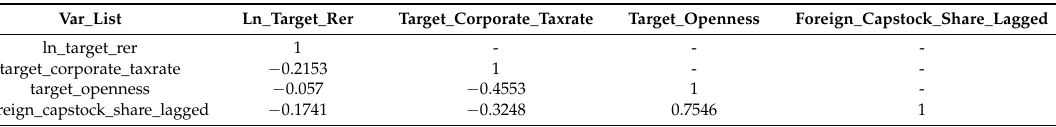
Figure A3. FDI inward stock UK, by industry, 2015. Source: Office for National Statistics, UK 2017.